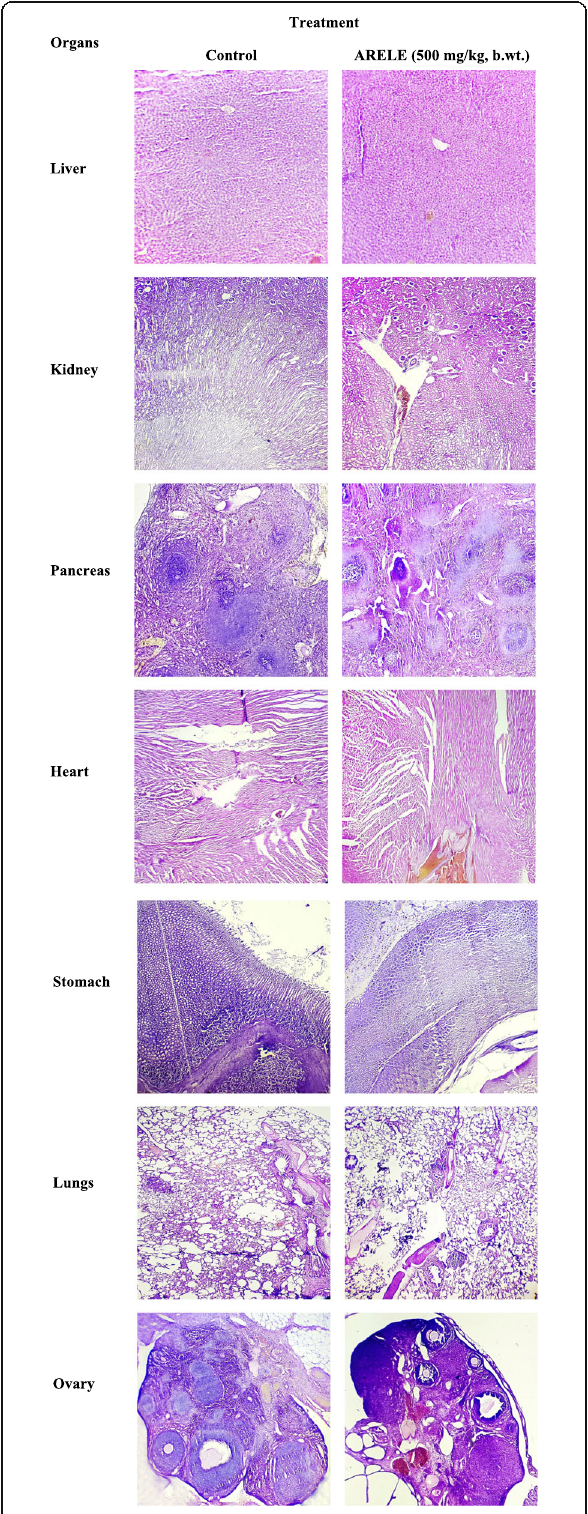
Fig. 4 Histopathological study of vital organs from female rats. Photomicrographs of histological findings of different organs from female rats treated with normal control vehicle and ARELE at high dose (500 mg/kg, b.wt.) for a period of 30 days (H&E staining, 40 ×